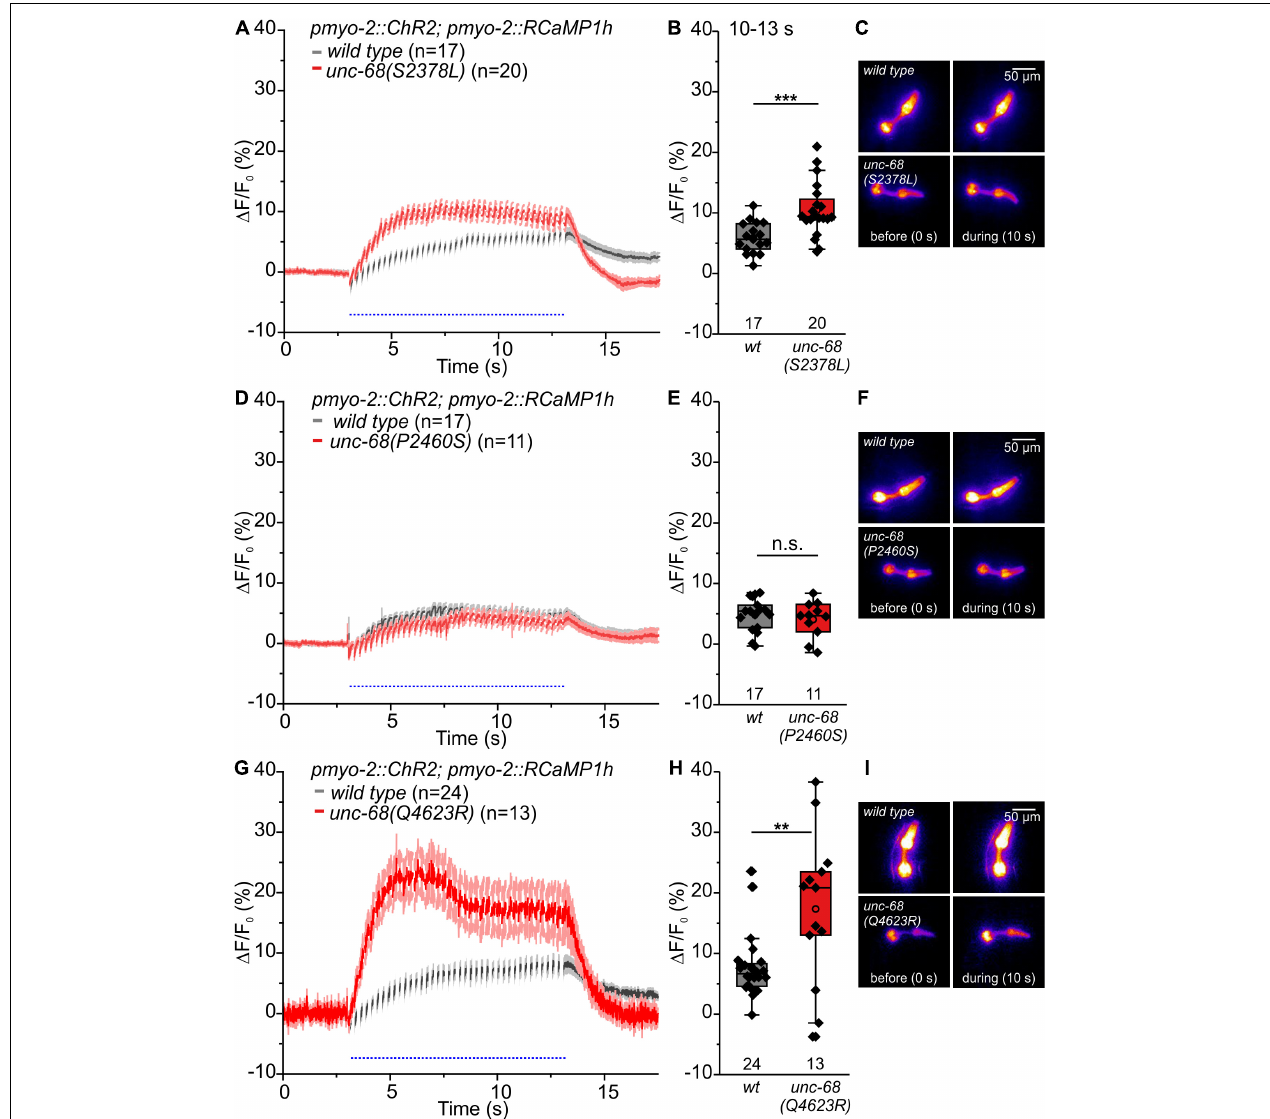
FIGURE 6 | RCaMP1h Ca 2 + imaging in PMC reveals effects of CPVT mutations inserted into unc-68 on cytosolic Ca 2 + concentration. (A,B,G,H) Alleles Q4623R and S2378L show an increase of (cid:49) F/F 0 in comparison to wt animals upon light stimulation (10–13 s). (D,E) Whereas allele P2460S does not exhibit a significant change (10–13 s). (C,F,I) Exemplary false-color representation of fluorescence intensity. Only worms that were able to follow 4-Hz stimulation have been included for analysis. Depicted is the mean of (cid:49) F/F 0 (%) with SEM, time periods ( ∼ 50 ms), including unspecific peaks induced by blue light stimulation, are not displayed here for better outline (A,D,G) . Box plots include every data point (rhomb), mean (open circle), and median (line). N-numbers and significance levels (asterisks) are located either below or above the corresponding boxes. T -test was performed for comparisons of the mean values during the plateau phase of the fluorescence rise (10–13 s): n.s., not significant, ** P ≤ 0.01, and *** P ≤